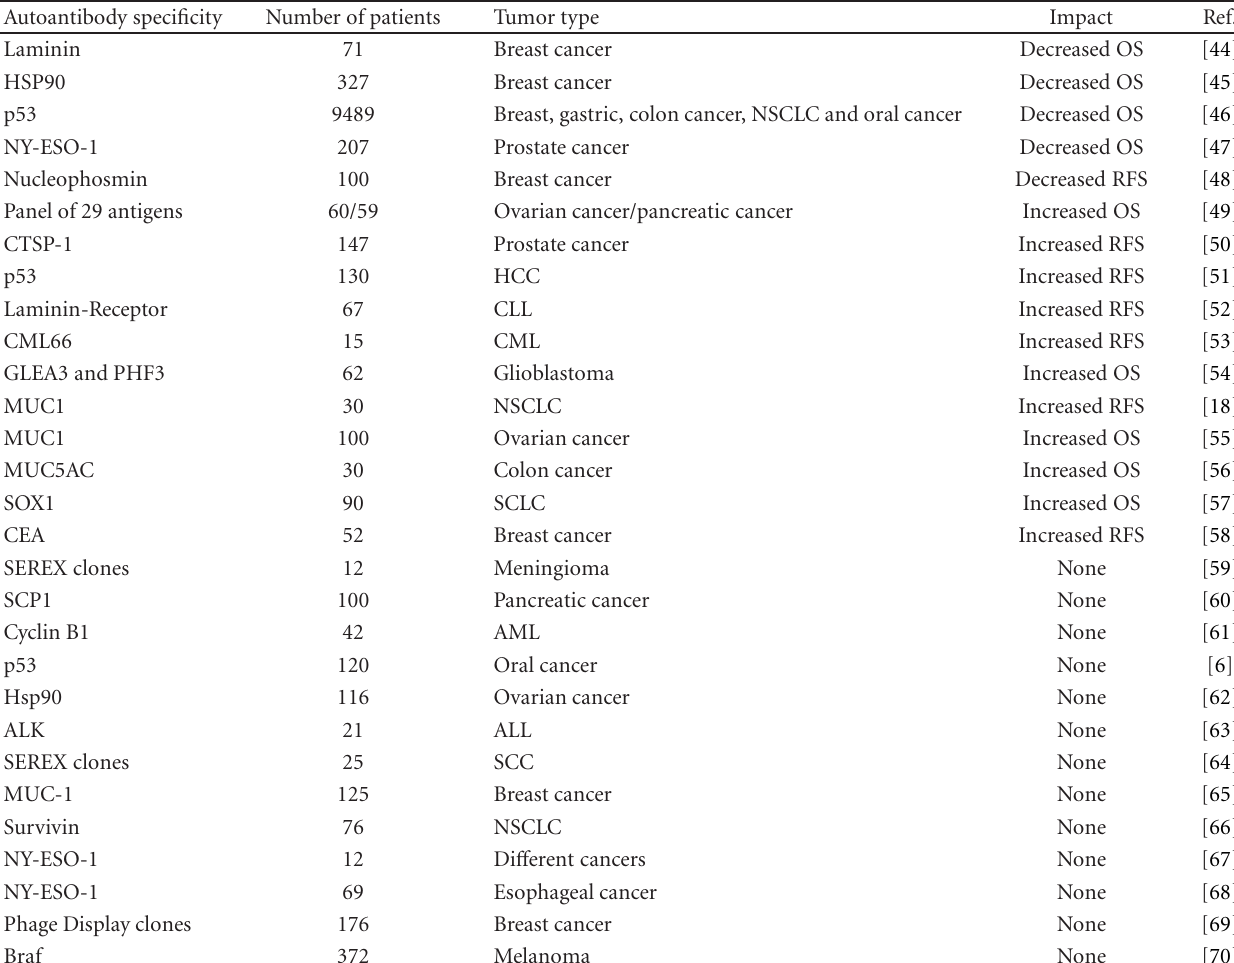
Table 2: Influence of autoantibodies against tumor-associated antigens on the prognosis of cancer